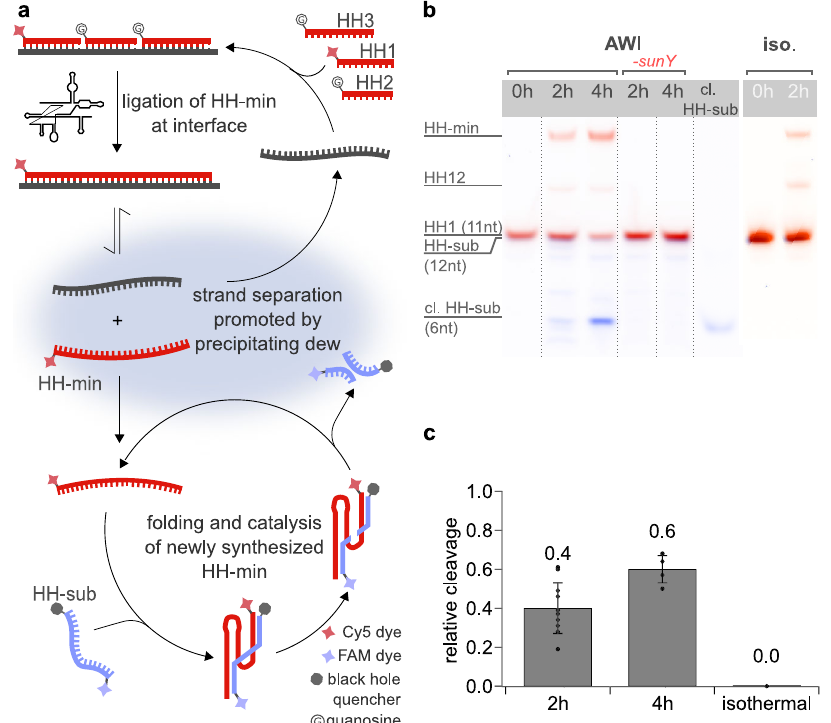
Fig. 3 | Templated synthesis and release of active hammerhead ribozyme. a sunY catalyzes template-dependent ligation of the hammerhead ribozyme (HH- min,red)fromthethreeRNAsubstrates(HH1-3,red).LocalvariationsinpHandsalt concentration cause strand separation, releasing ligated HH-min, which can then bindtoandcleaveitssubstrate(blue). b LigatedHH-min(red,Cy5)wasobservedin both the non-equilibrium and isothermal environments after 2h of incubation. Formation of cleaved hammerhead substrate (HH-sub, blue, FAM) was observed only after incubation under non-equilibrium (AWI) conditions. Control experi- ments without sunY ribozyme exhibited no HH-min assembly or HH-sub cleavage,